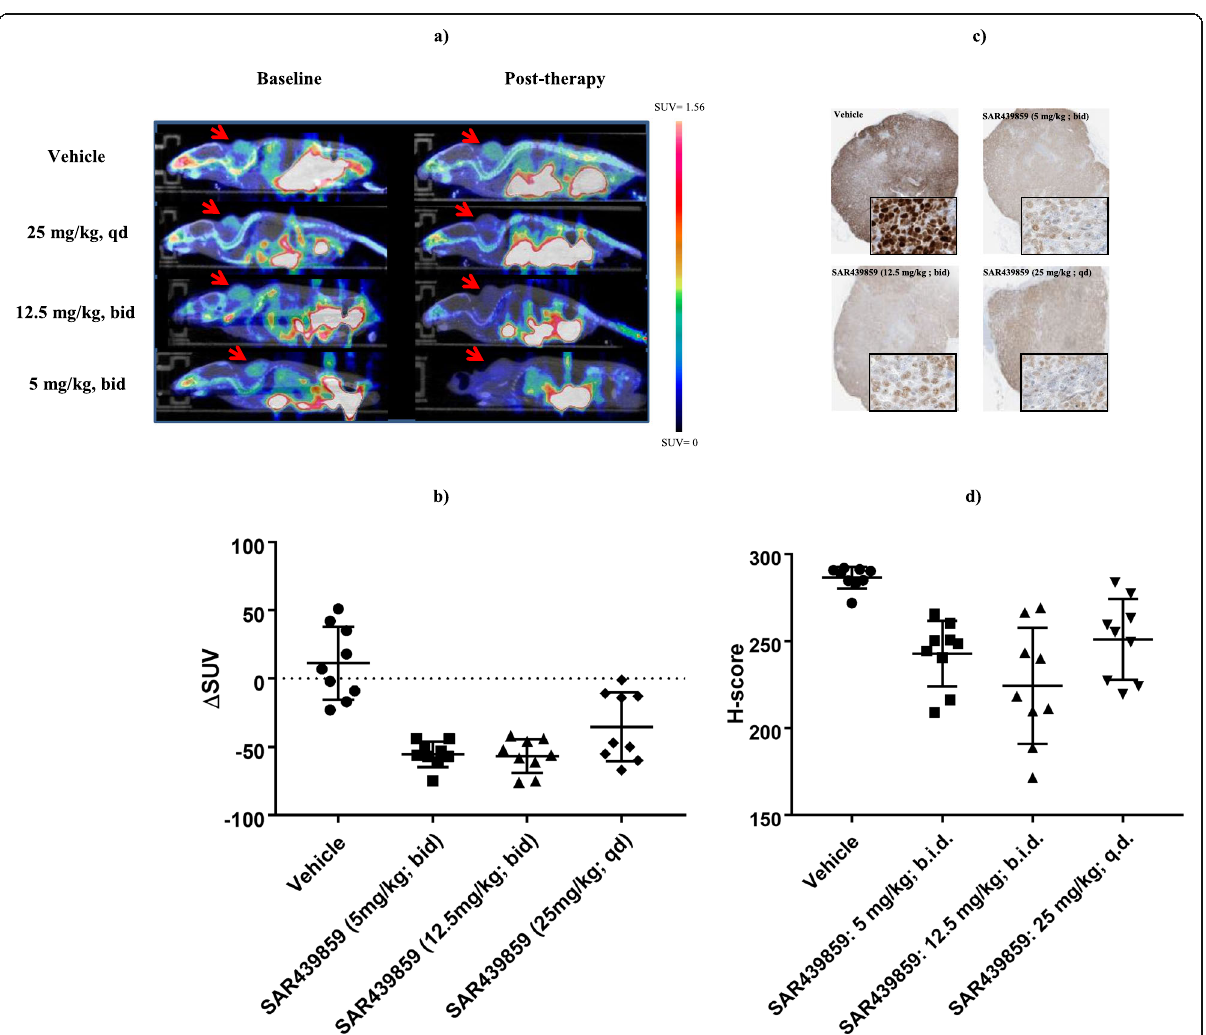
Fig. 2 a Co-registered FES-PET/CT imaging of MCF7-Y537S xenograft tumor-bearing mice at 8 h (bid regimen) or 24 h (qd regimen) after 4 days of administration of SAR439859. b Individual data and mean ± SD of Δ SUVmean for [ 18 F]-FES uptake during different regimen of SAR439859 treatment. c ER α staining and d ER-positive cells quantification in vehicle and SAR439859-treated tumor